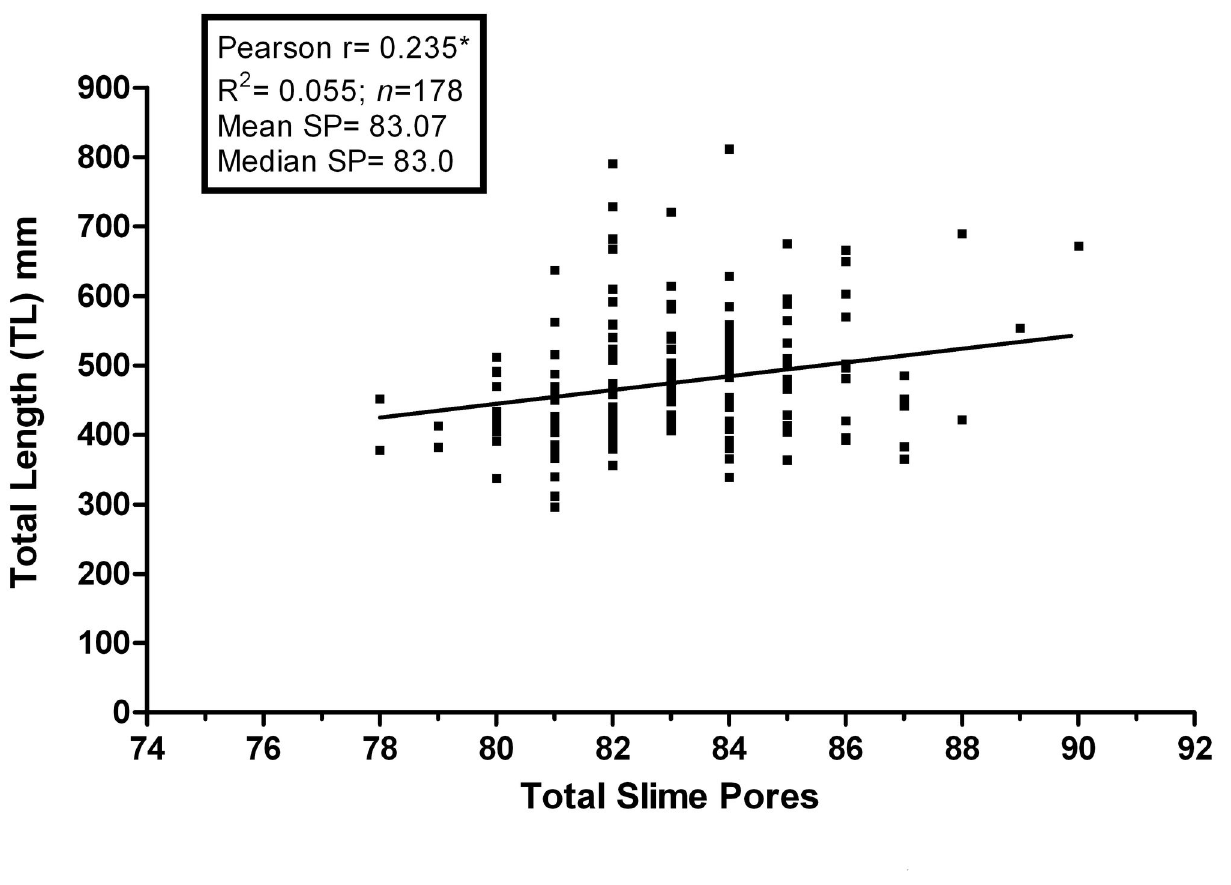
Figure 5. Total slime pore count plotted against TL. The number of slime pores increases significantly as the hagfish grow in length